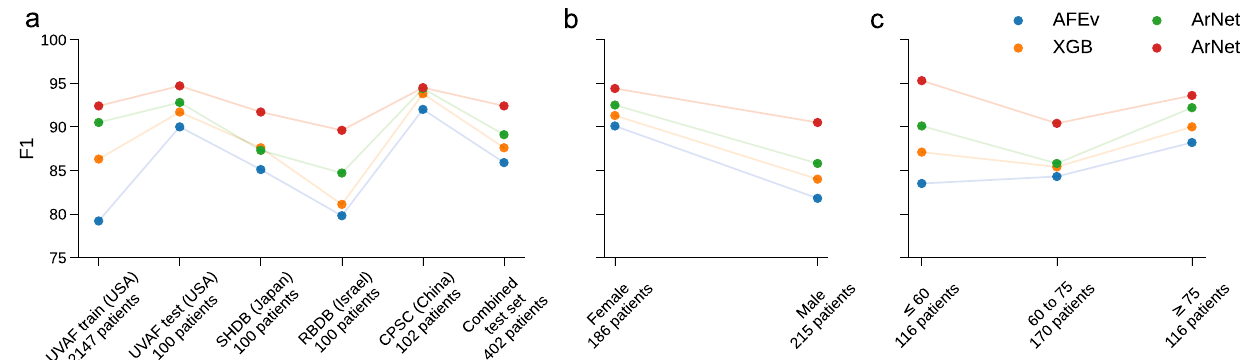
Fig. 3 F1 performance for the machine learning models across different distribution shifts. Performance for XGB, ArNet, ArNet2 and a rule- based approach AFEv 17 in classifying AF l events across geography ( a ), sex ( b ) and age ( c ).